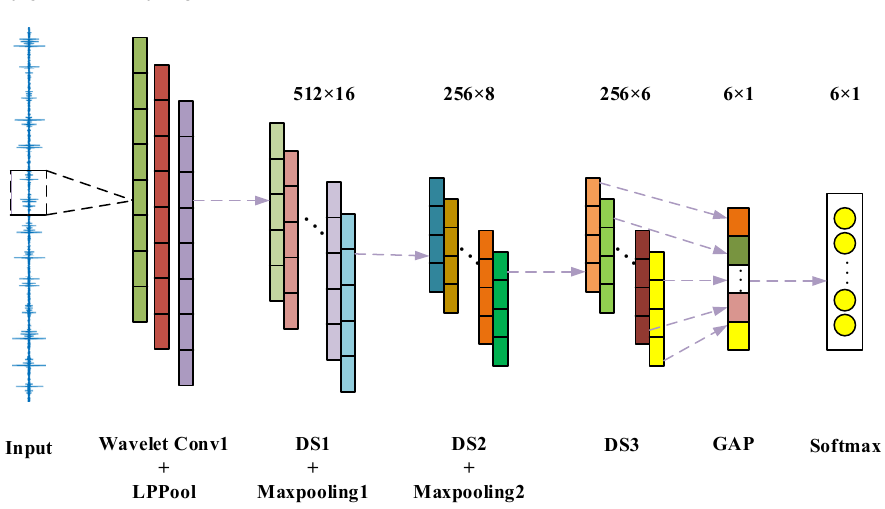
Figure 5. 1D-WL-G-MN network structure. Table 1. 1D-WL-G-MN network parameter.